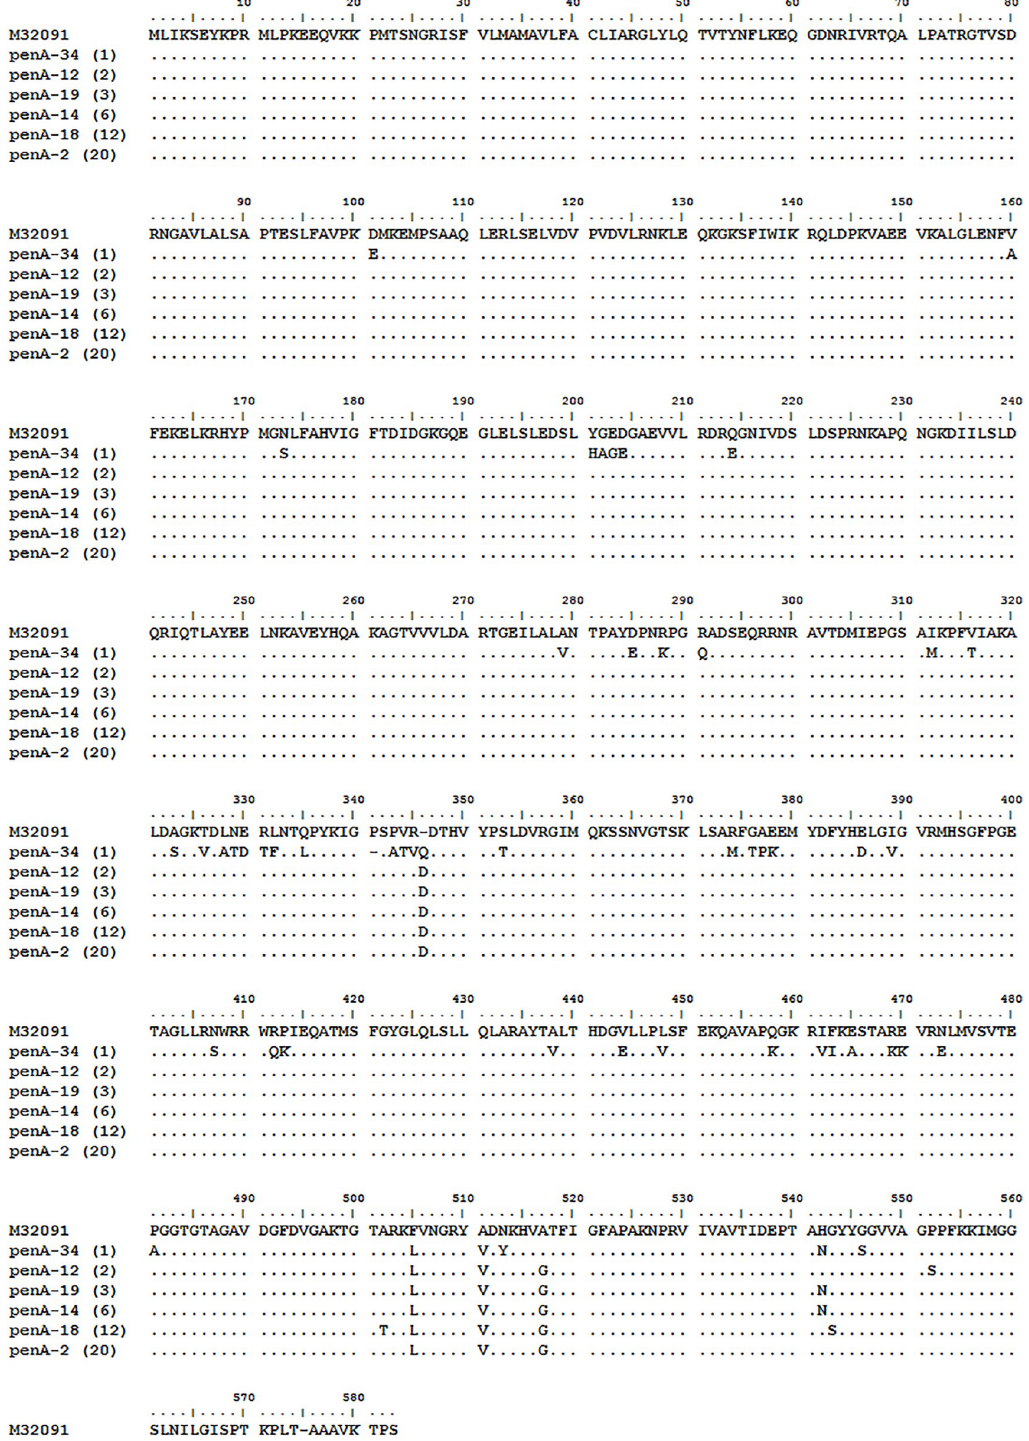
PLOS ONE | https://doi.org/10.1371/journal.pone.0223598 October 10, 2019 8 /